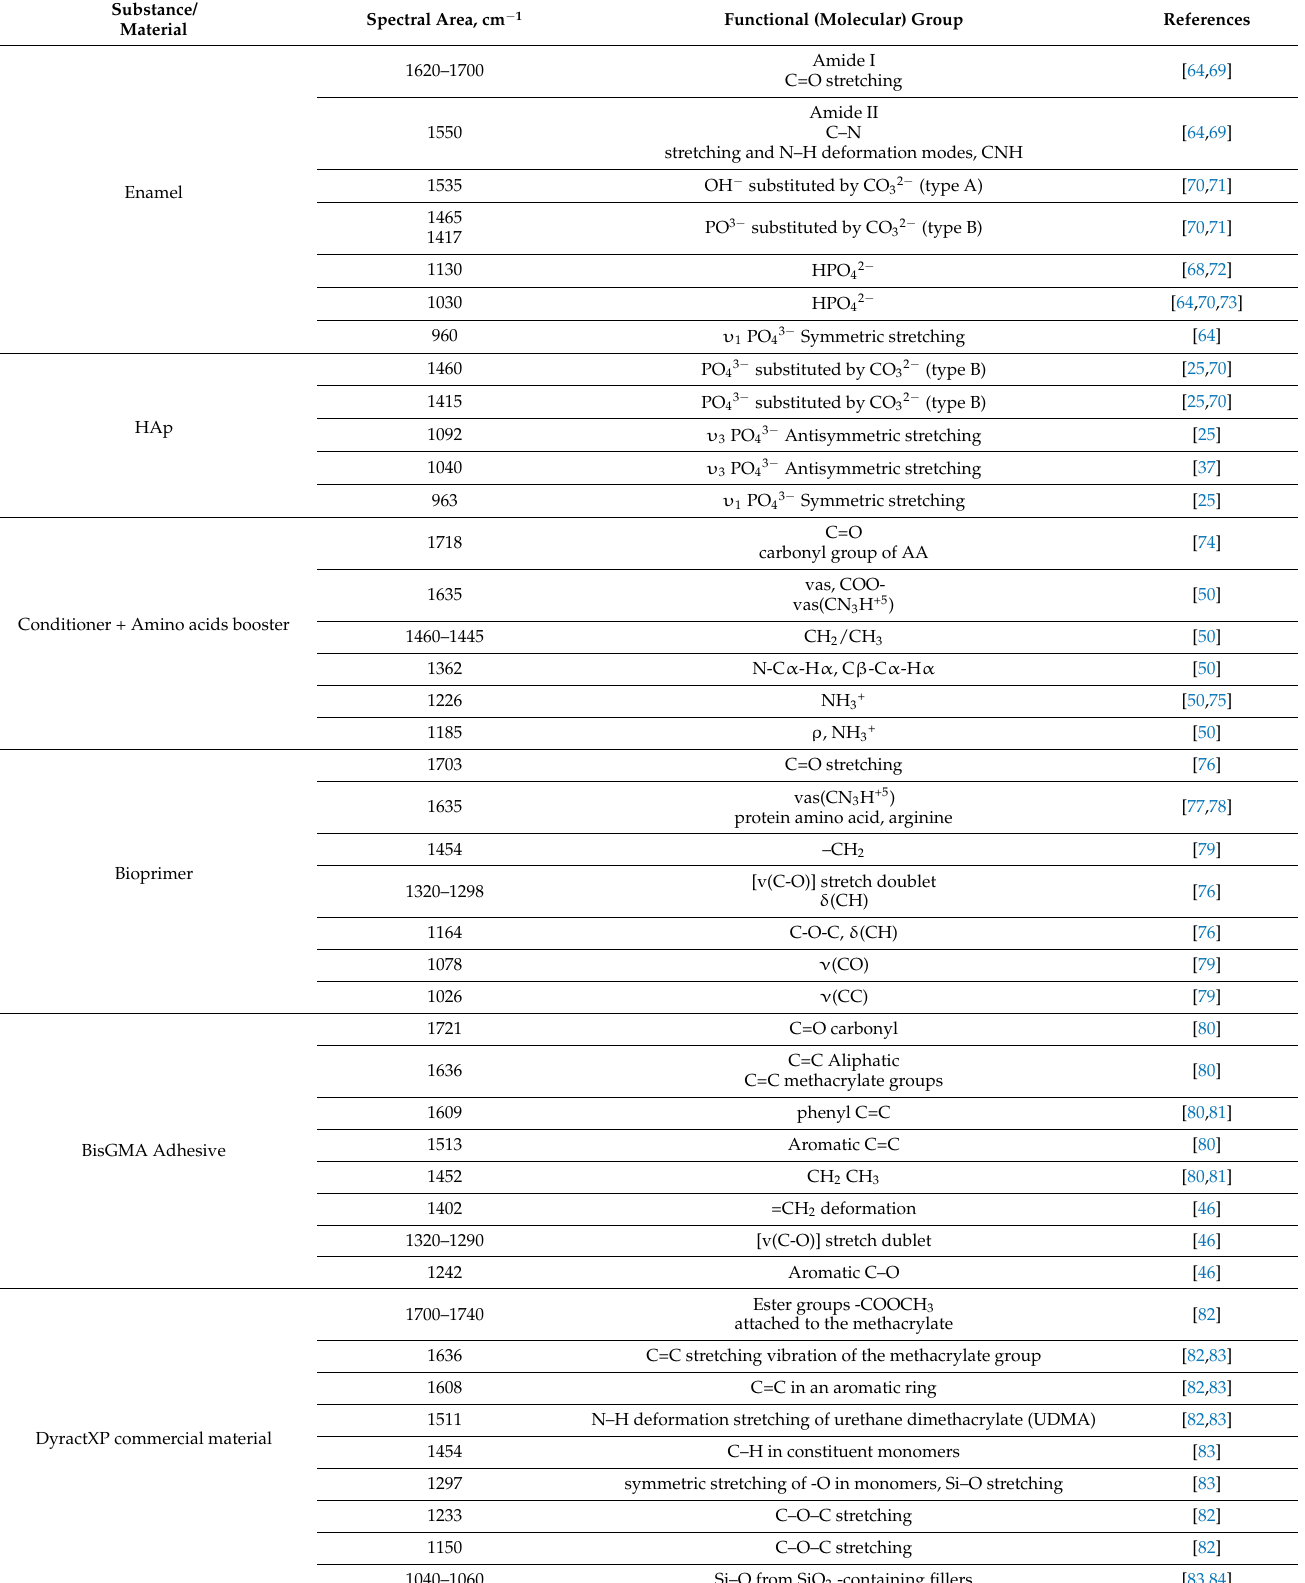
Table 2. Main vibrations in the infrared spectra and their belonging to the functional groups of the materials or substances involved in the